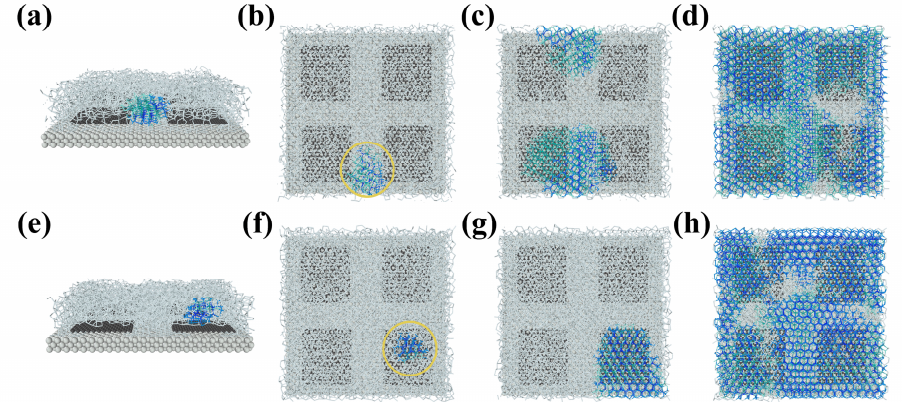
Figure 4. Snapshots of the preferential site of ice nucleation and subsequent growth of ice crystals on a metal–graphene surface. ( a ) Ice nucleation at the clearance of the surface, ε w-m = 4.0 kcal/mol. ( b – d ) Representative growth trajectories of an ice nucleus that appeared at the clearance, which is indicated by a yellow circle (from the top view). ( e ) Ice nucleation at the top of the graphene nanosheet, ε w-m = 1.0 kcal/mol. ( f – h ) Representative growth trajectories of an ice nucleus that appeared at the top of the graphene nanosheet. Silver and black spheres represent metal and carbon atoms. White sticks covered on them represent liquid water molecules, and blue and green sticks connect pairs of ice molecules with hexagonal and cubic structure orders, respectively.